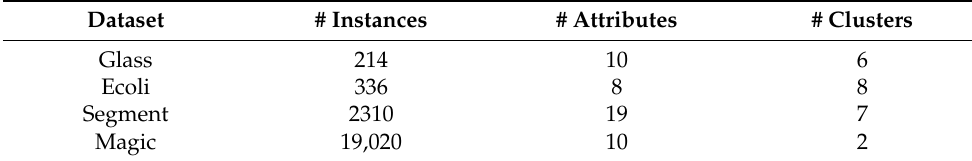
Table 1. The Data Sets Used in the